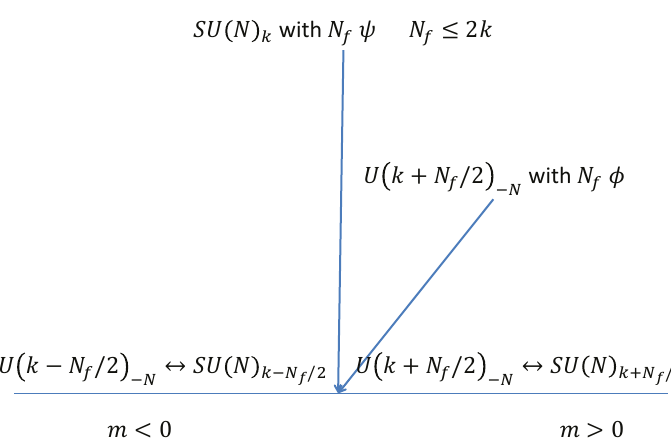
Figure 1 . The phase diagram of SU( N ) k for N f (cid:20) 2 k . We de(cid:12)ne the transition point to be at m = 0. The gapped phases have topological (cid:12)eld theories, SU( N ) level-rank duality of spin theories to U( k (cid:6) N f = 2) [3]. For k = N f = 2 the phase for negative m is